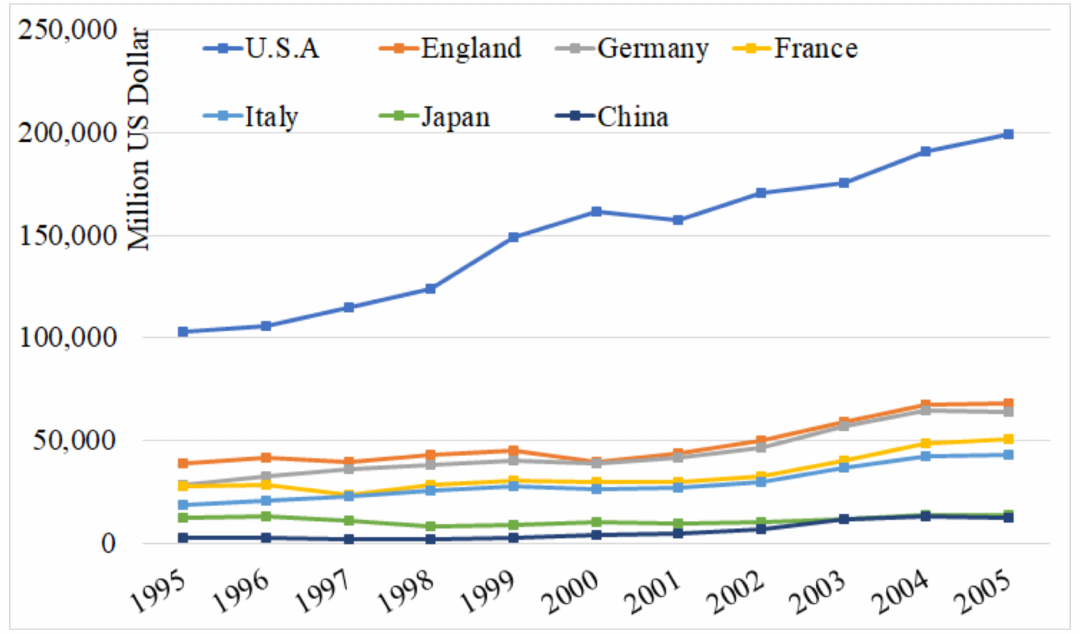
Figure 2. Vehicle import value of each country from 1995 to 2005